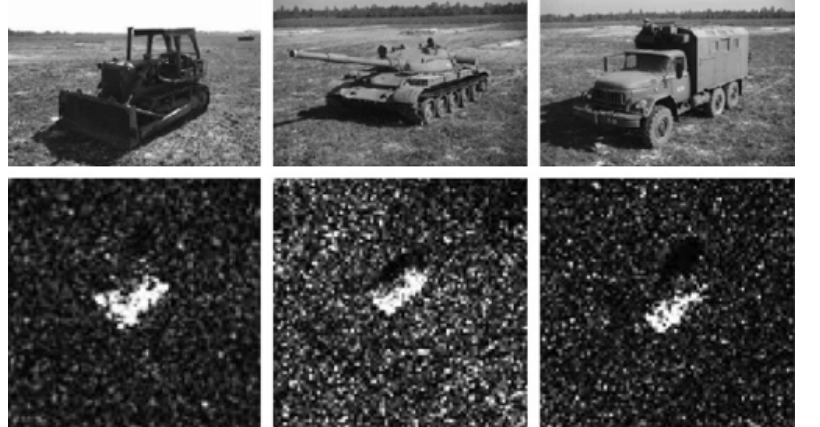
Figure 6. Camera images and corresponding SAR images from MSTAR database